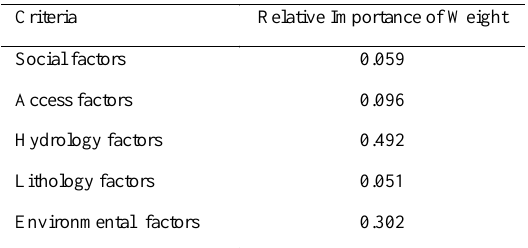
Table 3: The final weight of the criteria and the